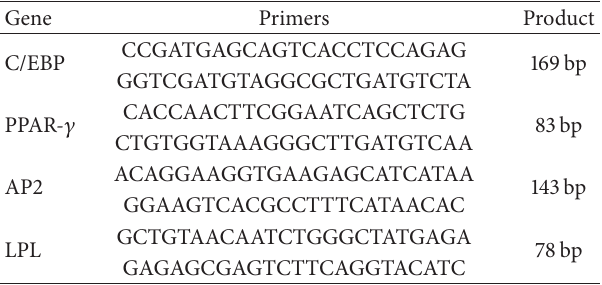
Table 3: The primers sequence for